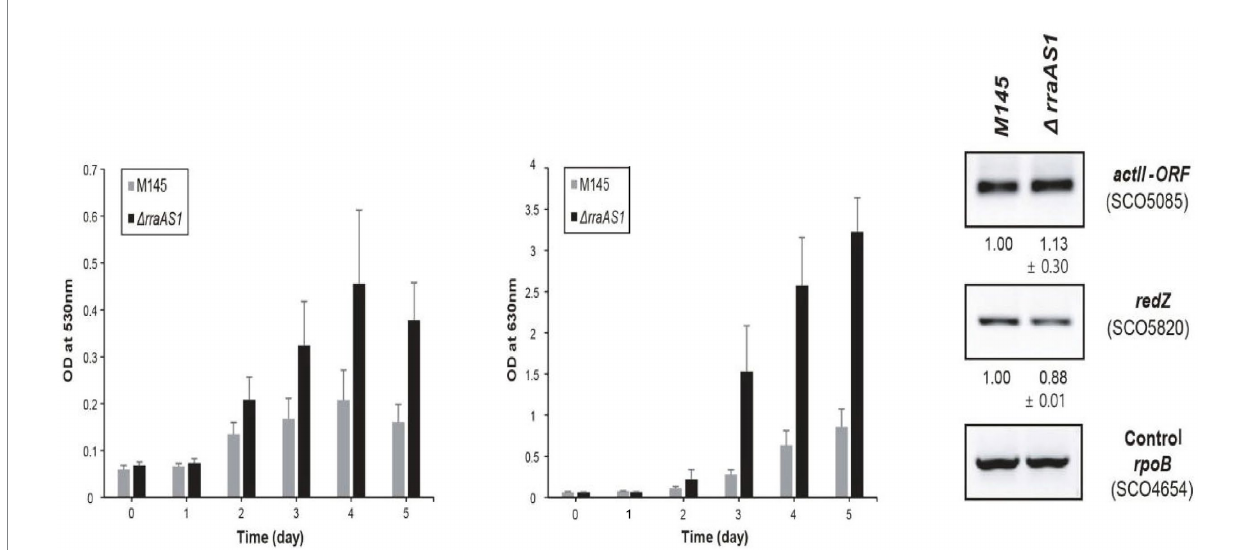
FIGURE 1 Overproduction of red (right bar graph) and act (left bar graph) by an rraAS1 null mutant of S. coelicolor . The antibiotics were measured using spectroscopic methods from mycelium harvested at the times indicated on the x-axis of the figures. The antibiotic concentrations were normalized relative to mycelial dry weights. The rightmost part of the figure shows the results of an RT-PCR analysis of the levels of the CSRs, actII-orf4 and redZ in the parental and rraAS1 null mutant strains of S. coelicolor . Reprinted with permission from Seo et al.